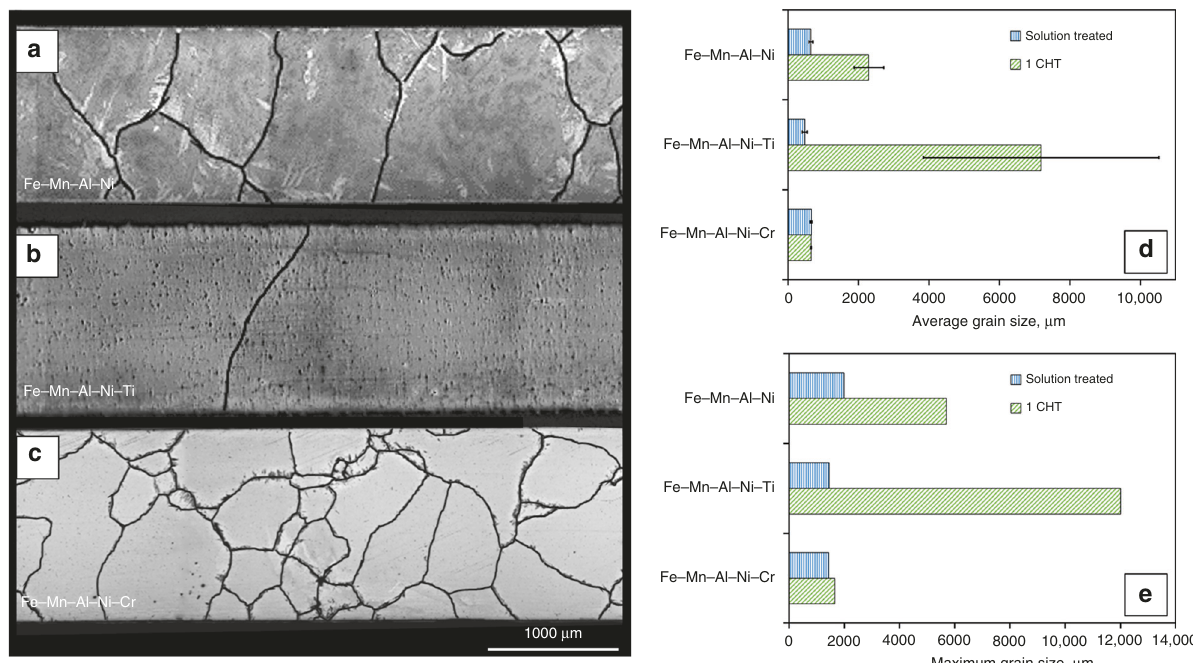
Fig. 2 Evaluation of grain growth behavior of Fe – Mn – Al – Ni – X (X = Ti, Cr). Optical micrographs of the characteristic microstructure with highlighted grain boundaries after a single cyclic heat treatment (cf. Supplementary Fig. 1a) for ( a ) Fe – Mn – Al – Ni, ( b ) Fe – Mn – Al – Ni – Ti, and ( c ) Fe – Mn – Al – Ni – Cr. Average grain size ( d ) and maximum grain size ( e ) after solution treatment at 1225 °C for 1 h and after a single cyclic heat treatment(cf. Supplementary Fig. 1a). Error bars in d indicate the standard deviation for the investigated